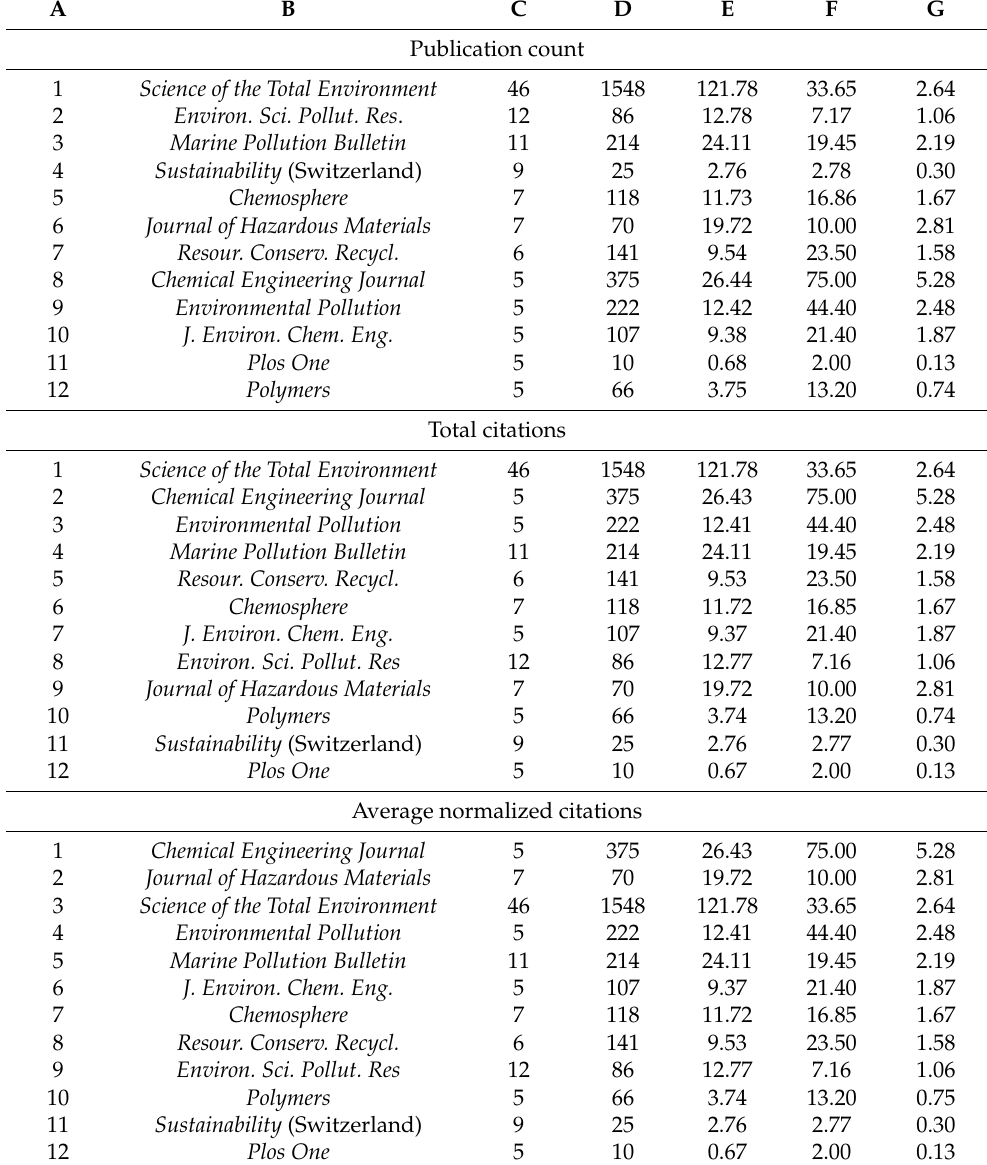
Table 1. Ranking of journals with more importance in the field in terms of total publication count, total citations, and average normalized